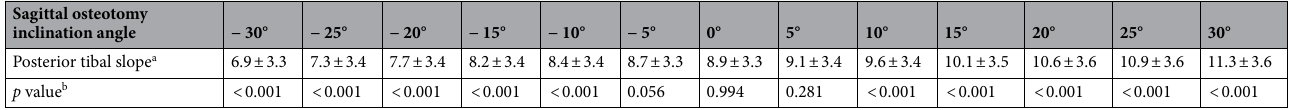
Table 5. Comparison between the postoperative posterior tibial slope after virtual osteotomy with each sagittal osteotomy inclination angle and preoperative posterior tibial slope (8.9 ± 3.2°) measured in the original preoperative tibial model. a The values are presented as mean ± standard deviation. b Analyzed by paired t -test.